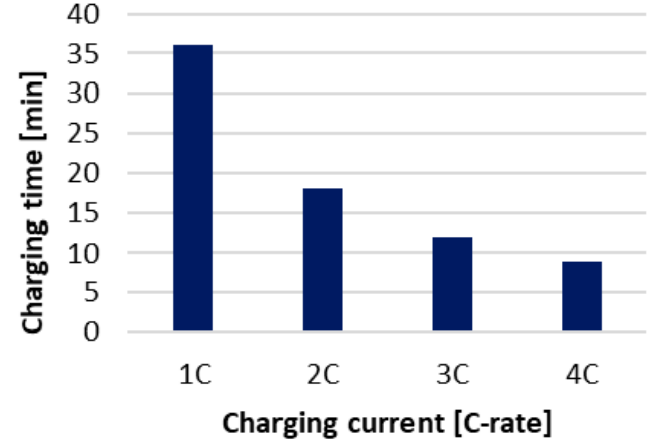
Figure 20. On-board ESS charging time. Table 4. On-board ESS scenarios.